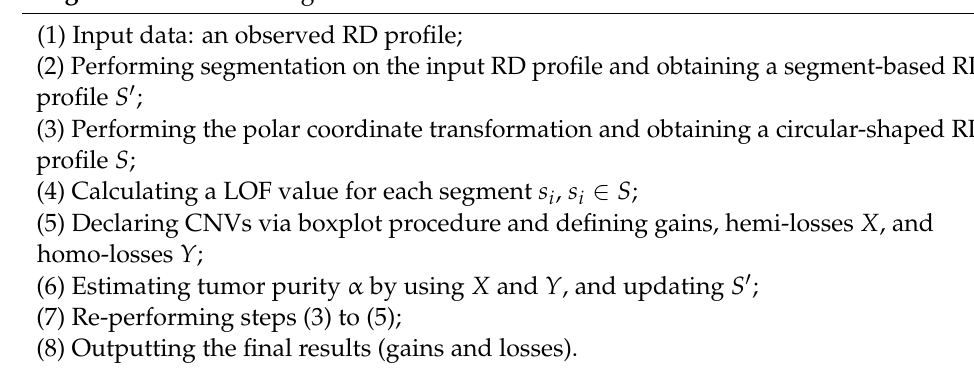
Algorithm 1 The core algorithm of